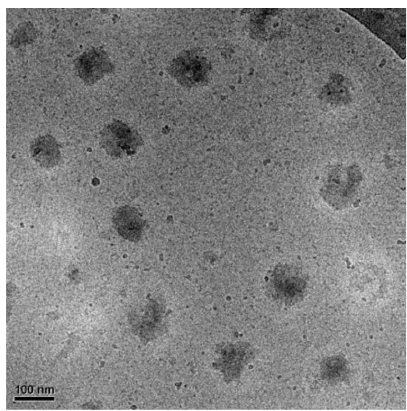
Figure 2. Cryo-transmission electron microscopy (cryo-TEM) image of microgel/pCD complexes prepared using pCD excess (c(+)/c( − ) = 2). The scale bar indicates 100 nm.